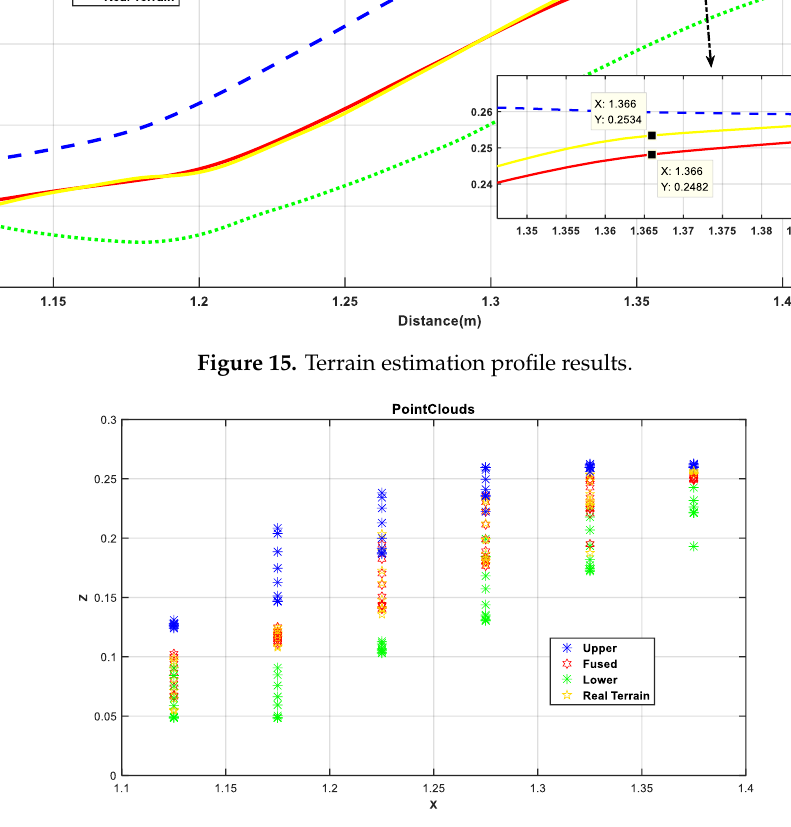
Figure 16. Terrain estimation section point cloud results.